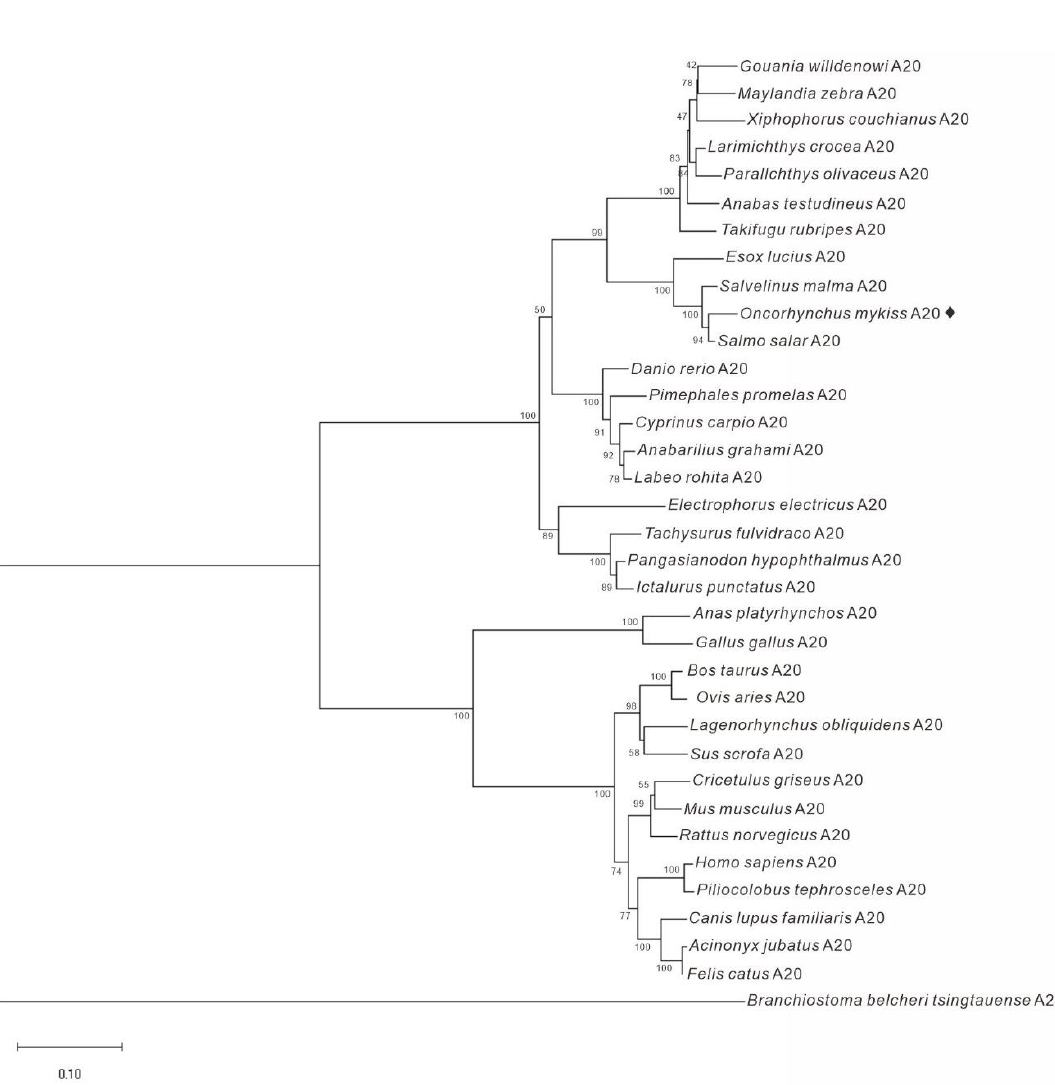
Figure 2. Phylogenetic tree analysis of A20 protein from various species. A phylogenetic tree analysis was carried out using the Neighbor-Joining method with 10,000 bootstrap replicates in the MEGA-X software.